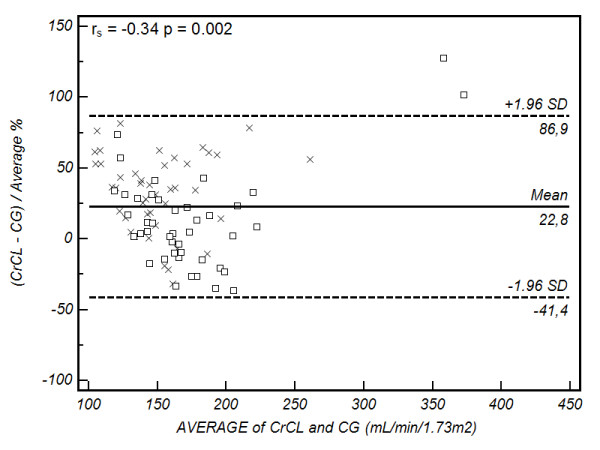
Bland-Altman plot of CLCR vs Cockcroft Gault formula. Comparison of the difference between the measured creatinine clearance (CLCR) and Cockcroft Gault (CG) formula (as a percentage) on the y-axis, versus the average value obtained on the x-axis. The solid line represents the bias (mean percentage difference obtained across the range of values), where as the dashed lines are the limits of agreement (+/- 1.96 × standard deviation (SD)). square, Australia cohort; cross, Portugal cohort. The Spearman correlation coefficient (rs) for the percentage difference and average value is provided in the top left hand corner (outliers excluded).